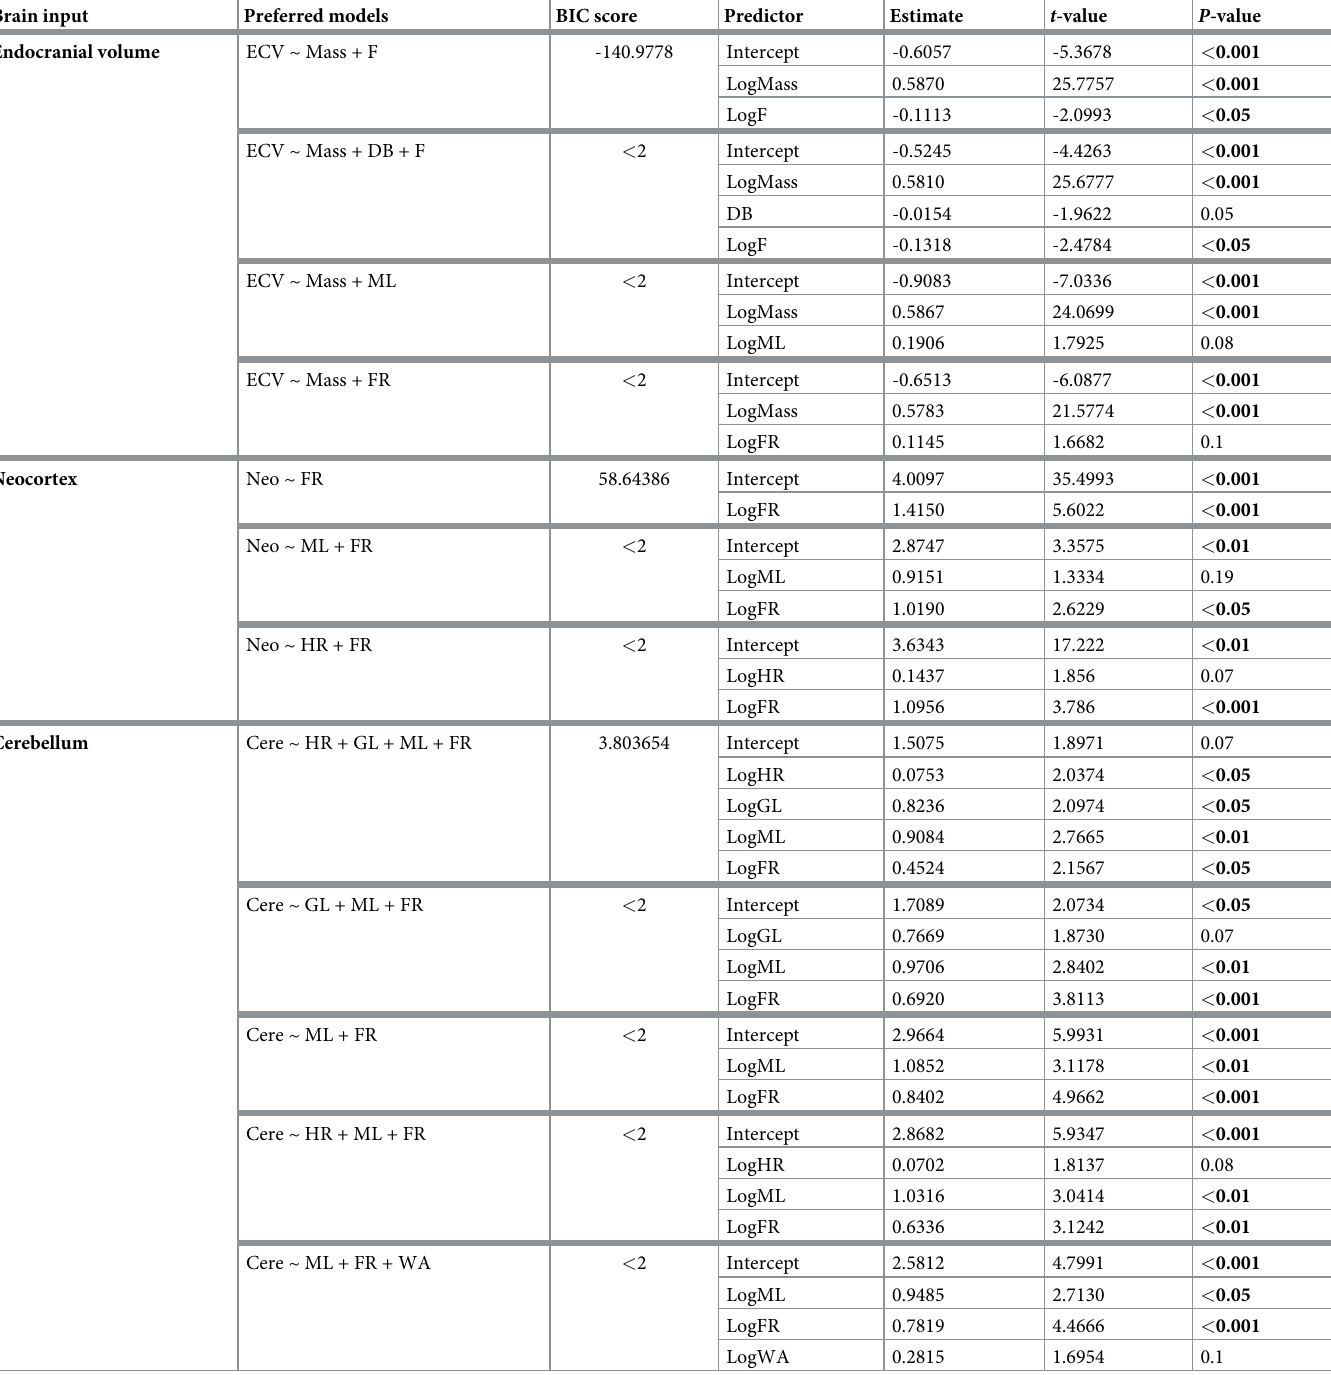
Table 4. Phylogenetic generalised least-squares (PGLS) regression analyses examining the effects of social, ecological and life-history variables � on carnivoran whole and regional brain volumes. Preferred models represent all the ‘ best fit ’ models for each brain input, which in most cases represents a subset of models (any model within dBIC < 2 of the lowest model). This can include any category of model (i.e., social or combined), and is dependent on the BIC score produced. Boldness indicates <